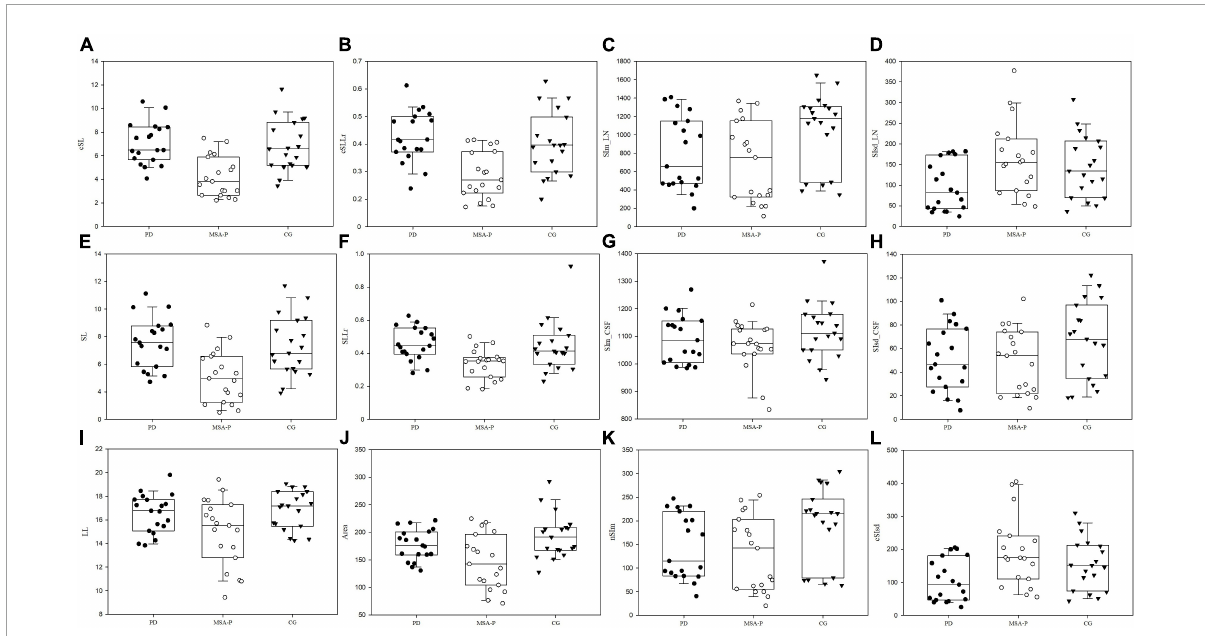
FIGURE2 The box-scatter blot of the three groups with upper lower limit, upper lower quartile, and median line. The x -axis represents the three groups using different colors, and the y -axis represents the measured and calculated indexes. (A) corrected short line, cSL, (B) corrected short and long line ration, cSLLr, (C) mean signal intensity of lentiform nucleus, SIm_LN, (D) standard deviation of signal intensity of lentiform nucleus, SIsd_LN, (E) Short line, SL, (F) the ratio of short and long line, SLLr, (G) mean signal intensity of cerebrospinal fluid, SIm_CSF, (H) standard deviation of signal intensity of cerebrospinal fluid SIsd_CSF, (I) long line, LL, (J) Area, (K) normalized mean signal intensity, nSIm, and (L) corrected standard deviation of signal intensity, cSIsd.